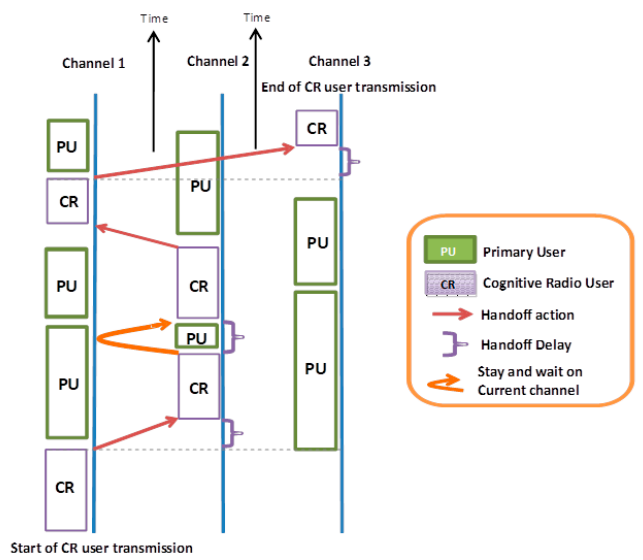
Figure 4. Time stream of the CRU transmission in the hando ff